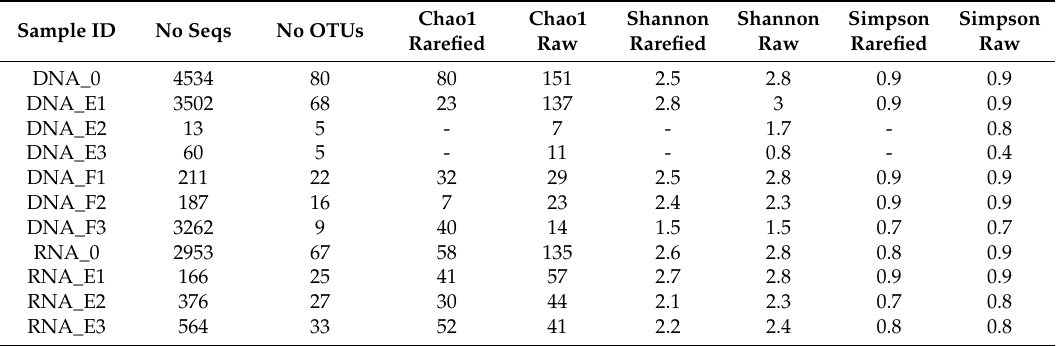
Table 5. Alphadiversity analysis of the bacterial community detected from the DNA and RNA of the original fracture fluid (DNA_0 and RNA_0, respectively), enriched microcosms (DNA_E1-3 and RNA E1-3) and the acetate assimilating community detected from the labelled fractions (DNA-F1-3). This table presents both the number of sequences (No of Seqs) and OTUs (No of OTUs) along with Chao1 richness estimate and Shannon and Simpson diversity indices, respectively, and shows both raw data and normalized (rarefied) data based